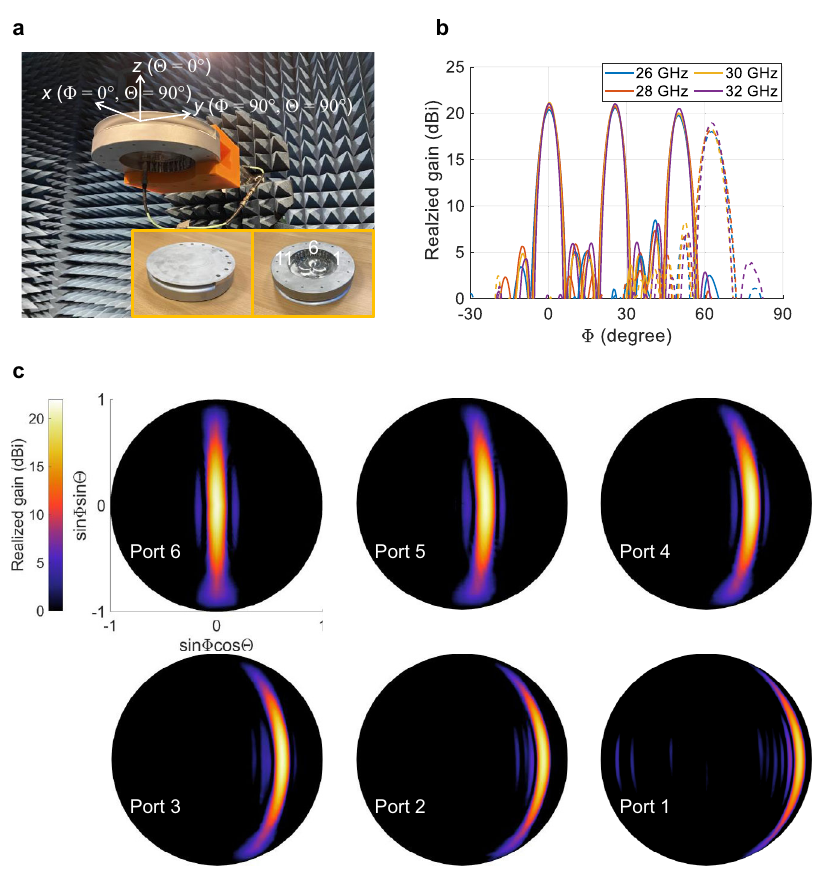
Fig. 9 Prototype and measurement. a Photo of the fabricated prototype and measurement setup in the far- fi eld aechoic chamber. b Measured realized gain across the frequency band in the beamforming plane Θ = 90 ∘ for selected ports 6, 4, and 2. For brevity, only half of the angular space is presented due to symmetry. c Contour maps of the measured realized gain at 30 GHz over the angular range up to Φ = 62.5 ∘ for beams generated from Port 6-1, with the same